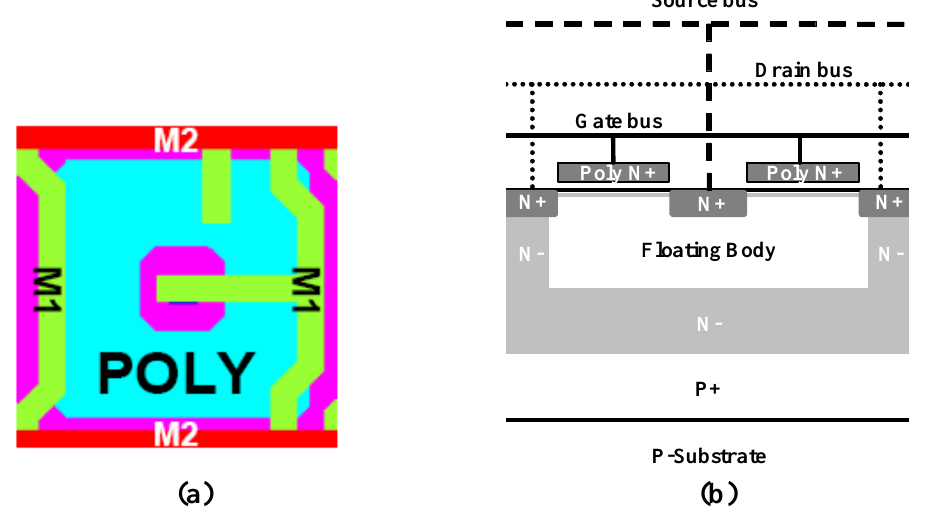
Figure 8. Ring-gate design of the 1 T pixel structure in a 0.13 µm CMOS process & 90 nm copper-based process. (a) 1.4 µm-pitch pixel layout. (b) Cross-section view of the implemented pixel structure.